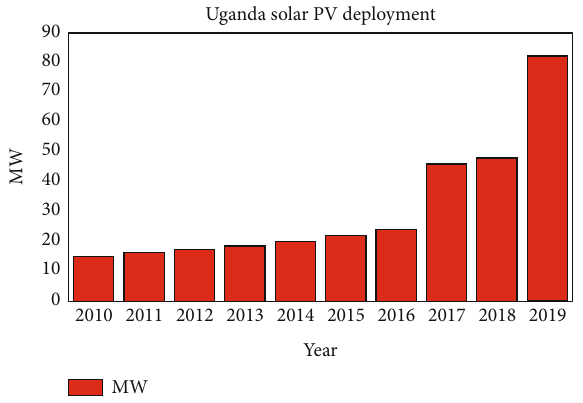
Figure 5: Solar PV deployment trends in Uganda by IRENA.